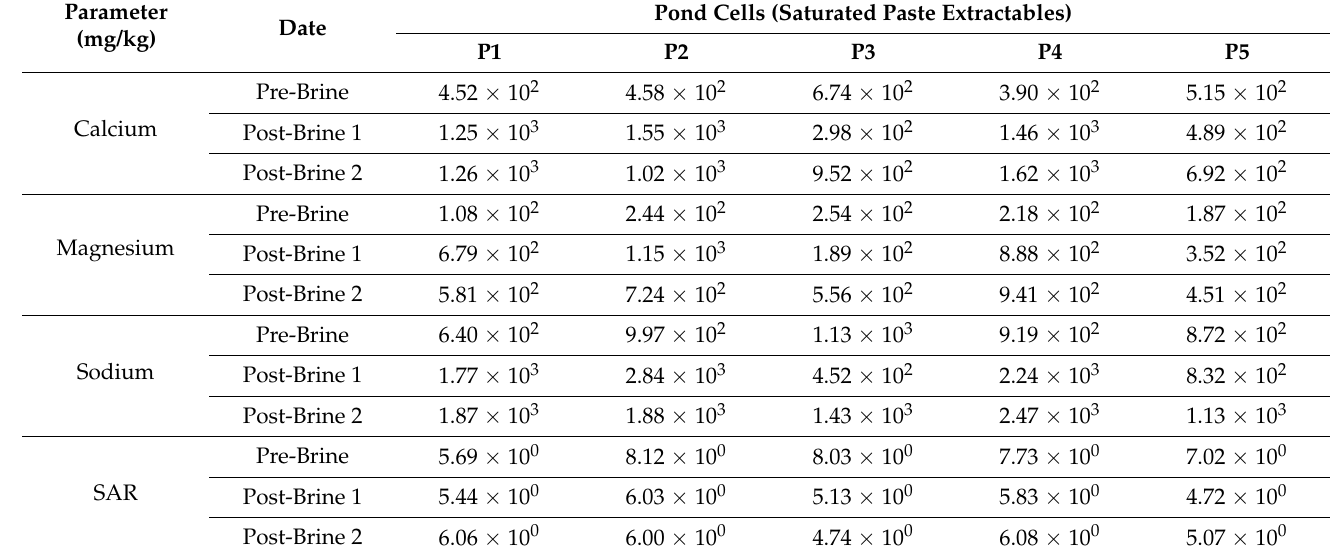
Table 5. Pond sediment analysis: Sediments collected (a) prior to daily brine discharge and (b) approximately 2 years after the start of routine brine discharge. Samples collected as post-brine 1 and 2 were collected approximately 1 month apart during summer.